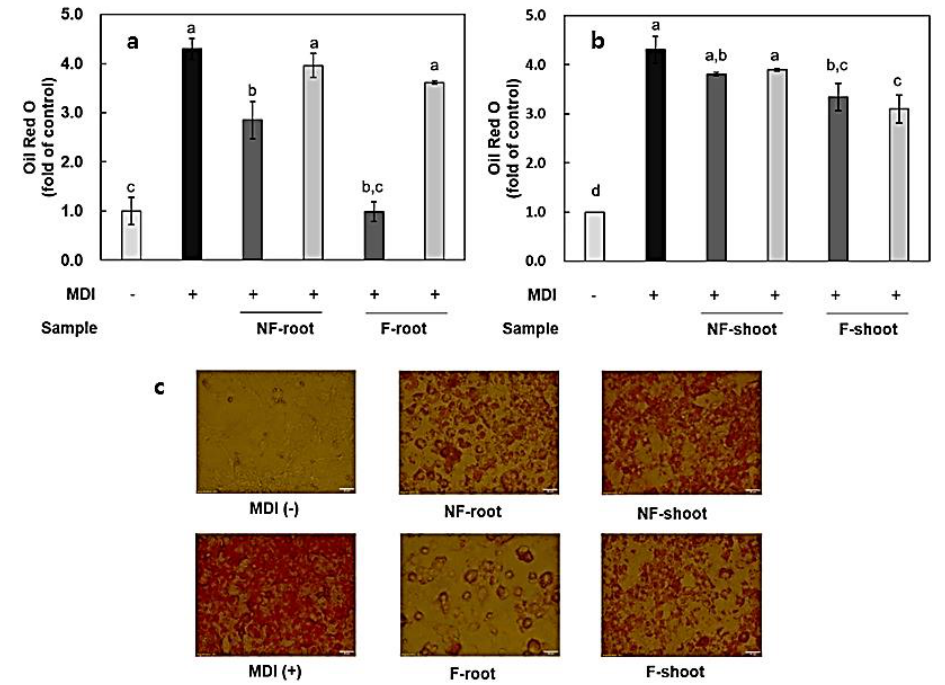
Figure 5. E ff ects of fermented hydroponic ginseng root ( a ) and shoot ( b ) on lipid accumulation in di ff erentiated 3T3-L1 cells, and Oil Red O (ORO) stained cells after di ff erentiation ( c ). 200 µ g / mL; 100 µ g / mL. NF, non-fermented; F, fermented; MDI, insulin + dexamethasone + 3-isobutyl-1-methylxanthine (IBMX). Values are means ± standard deviation of triplicate experiments. Di ff erentlettersindicatesignificantdi ff erencesasdeterminedbyDuncan’smultiplerangetests ( p < 0.05). Di ff erent letters (a, b, c, and d) represent significant di ff erences among